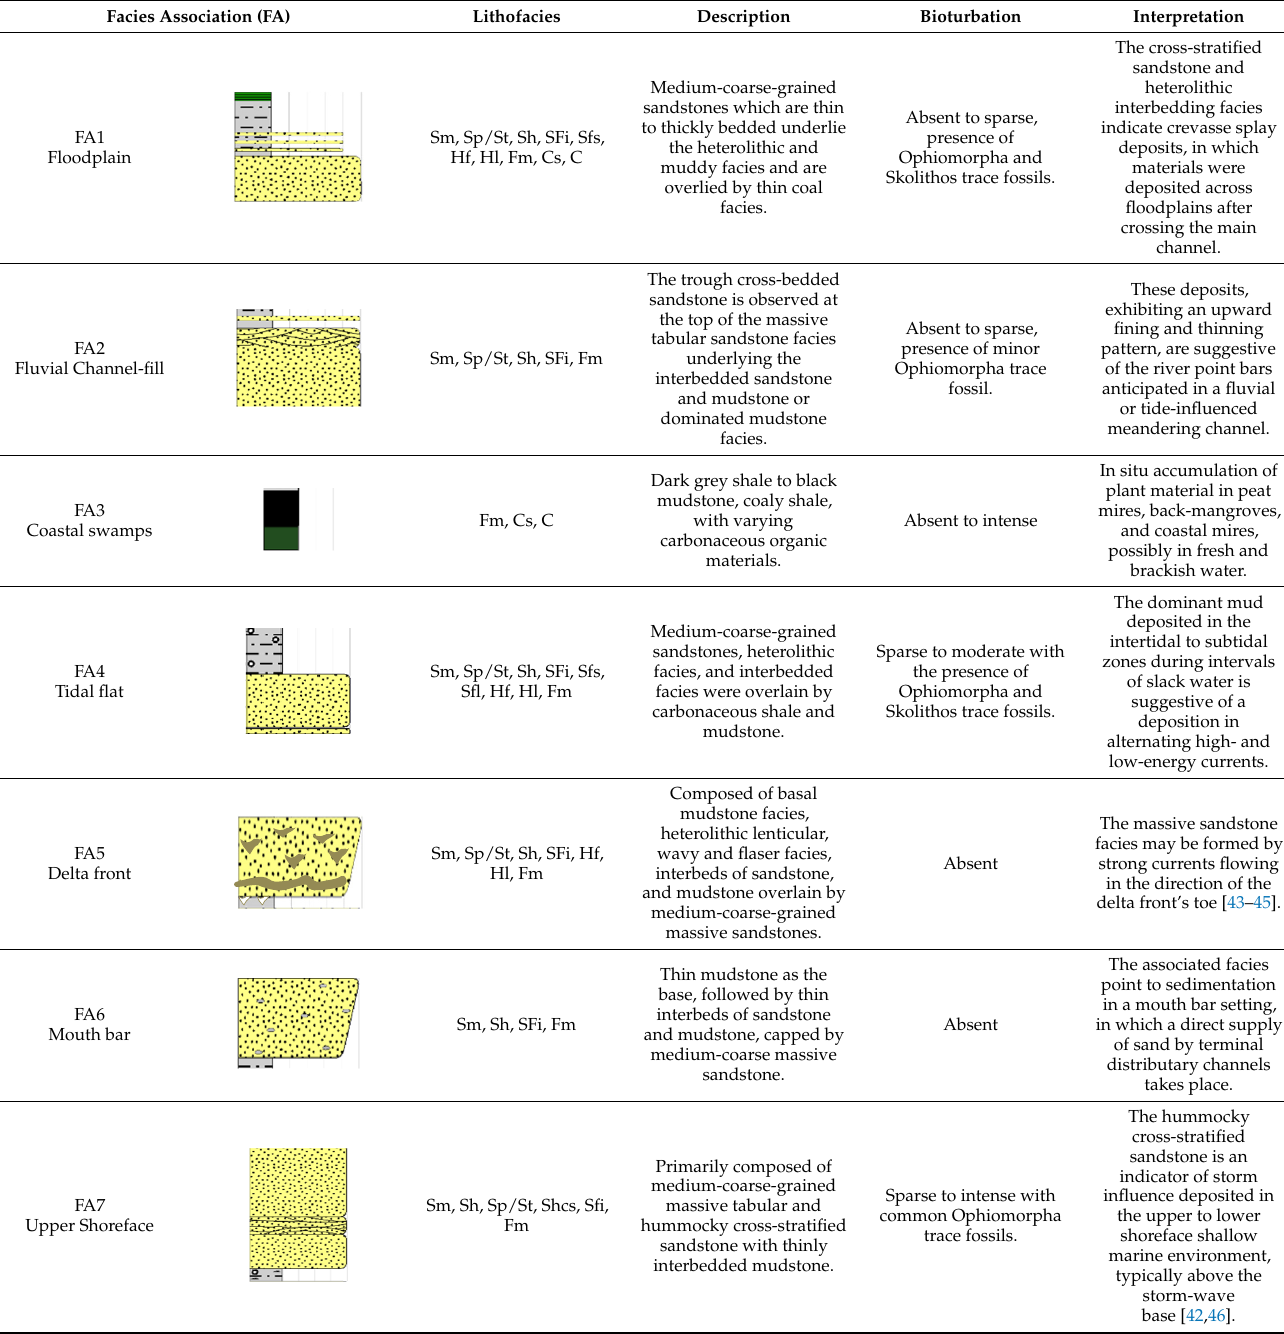
Table 2. Facies association characterization (FA1–FA7) of the Tanjong Formation in southeast, Sabah.